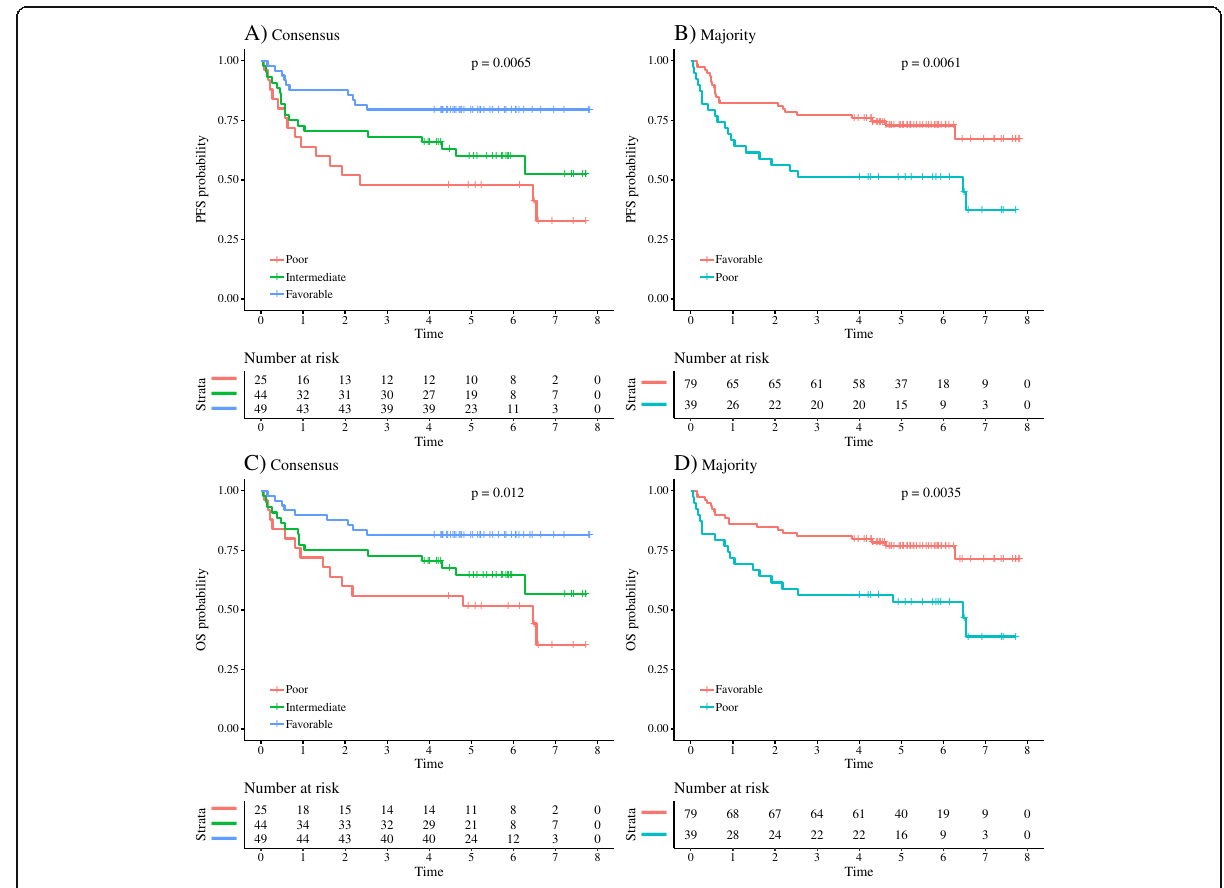
Fig. 3 Progression-free survival (PFS) and overall survival (OS) using the visual assessment of prognosis by expert readers. a , c The consensus diagnosis of the three readers with an intermediate group reflecting disagreement between reviewers. b , d Prognosis based on majority decision. As seen, both consensus and majority decisions were able to significantly identify high- and low-risk